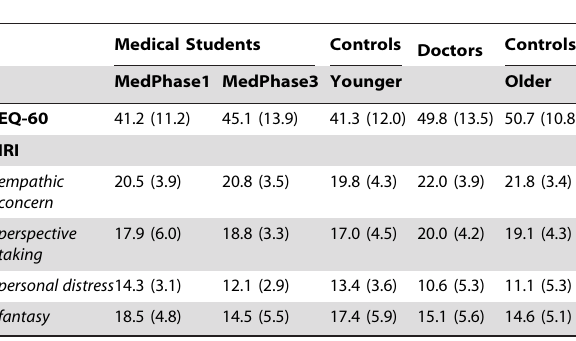
Table 2. Mean scores (and standard deviations in parenthesis, n =20 per group) obtained from the different empathy measures for the five participant groups.